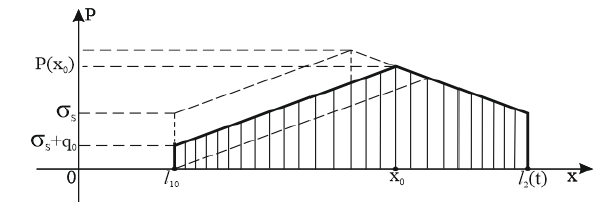
Fig.5. The distribution of contact pressure in the plastic strip (at the left end of which a tensile force 0 q s = − > is 0 xx